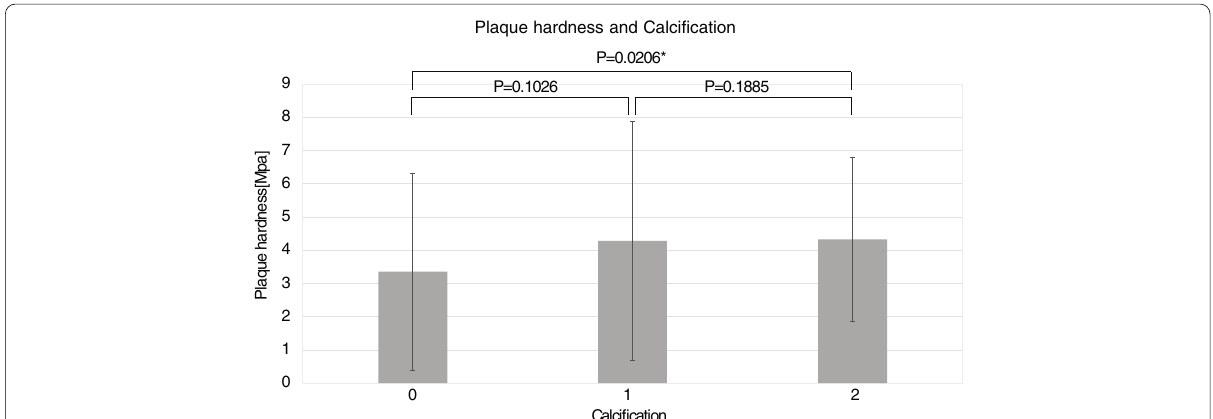
Fig. 5 Comparison of plaque hardness and semi-quantified calcification. "0" was no calcification, "1" was scattered microcalcification, and "2" was calcification of 1 mm or more or the presence of microcalcification of 2% or more of the total